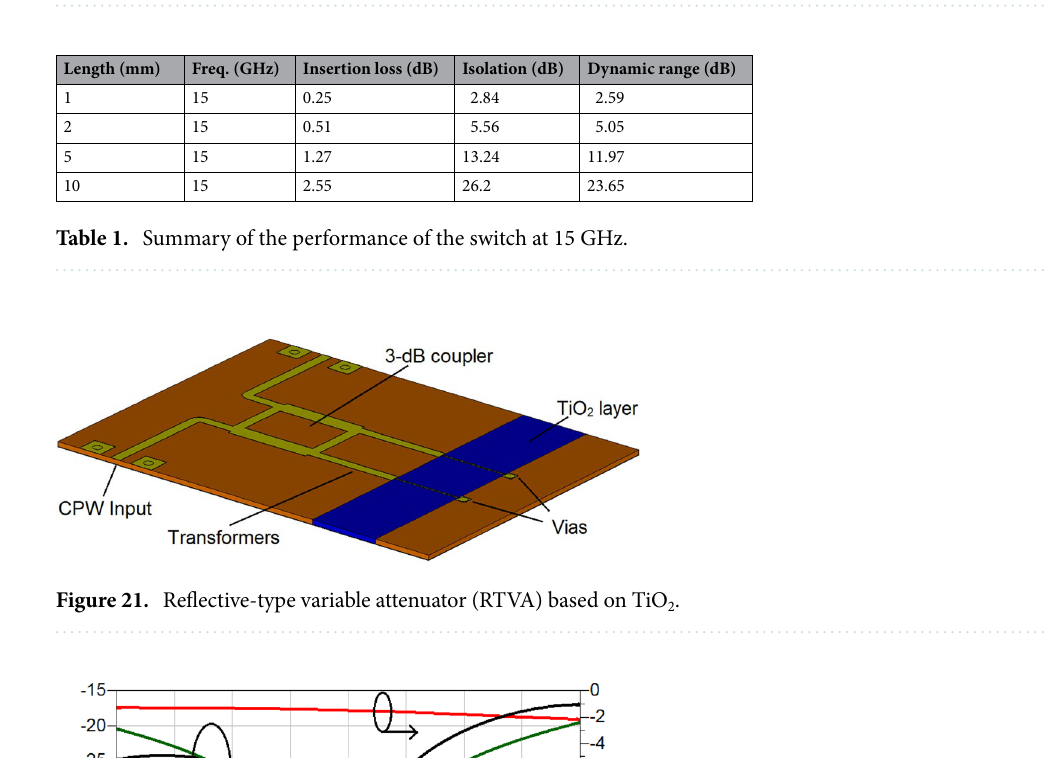
Figure 20. Performance of TiO 2 based switch as function of length; red, black and blue—OFF state for lengths of 1 mm, 2 mm and 5 mm respectively and green, orange and purple—ON state corresponding to the same lengths.